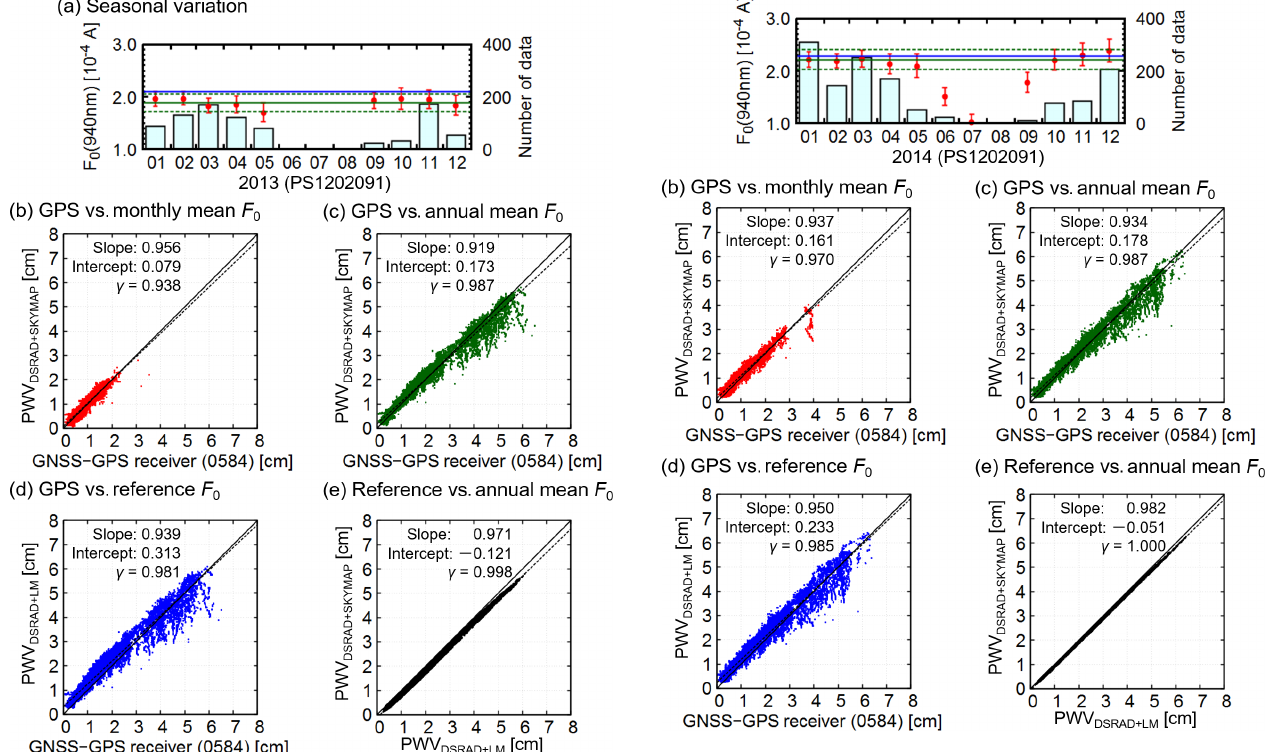
Figure 15. Application of our methods to observational data from Tsukuba in 2013. (a) Seasonal variation in the calibration constant of the water vapor channel (red circles and error bars are monthly means and standard deviations, respectively; green solid and dotted lines are annual means and standard deviations, respectively; the blue line is the value obtained by a side-by-side comparison with the reference sky radiometer; boxes indicate the number of data points). (b–d) Comparisons of PWV between the GNSS–GPS receiver and the sky radiometer with (b) the monthly mean F 0 , (c) the annual mean F 0 , and (d) the reference F 0 . (e) Comparison of PWV from the sky radiometer with the reference and annual mean F 0 .